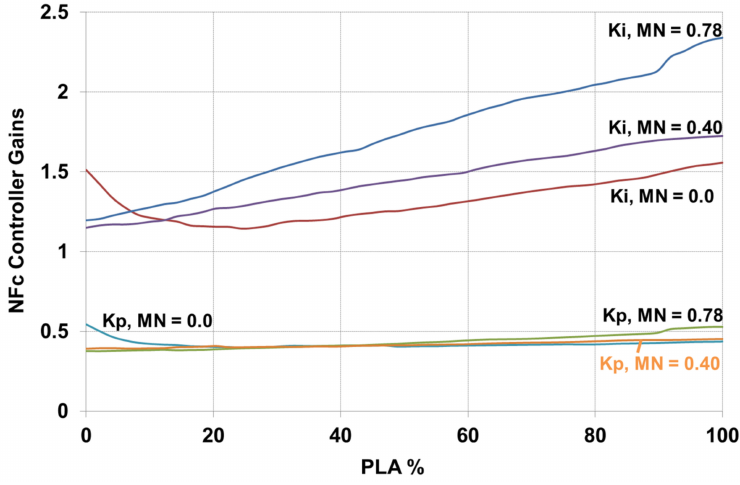
Figure 11. Kp and Ki gains of the Nfc setpoint controller.